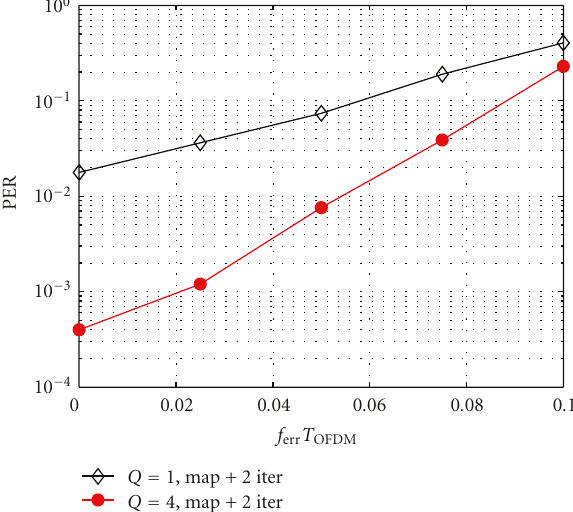
Figure 7: E ff ect of channel frequency o ff set (CFO) in Configuration 1 with and without GO-CDM